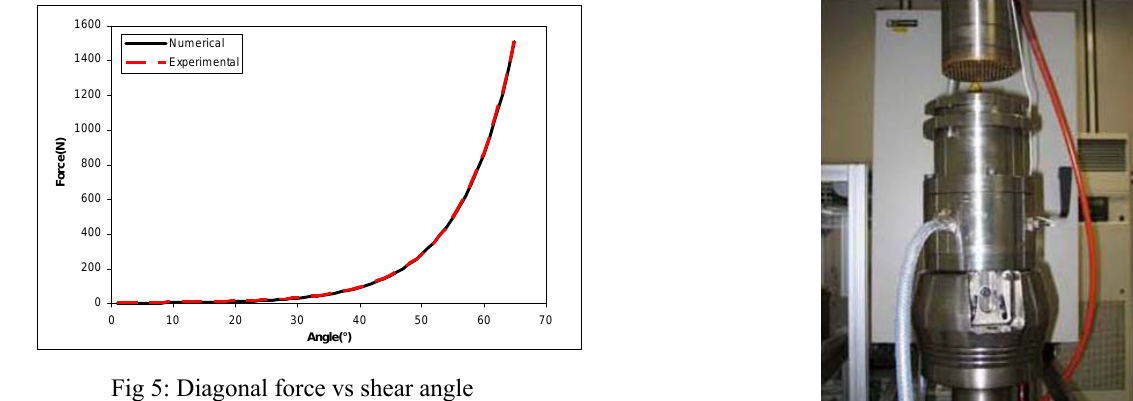
Fig 5: Diagonal force vs shear angle